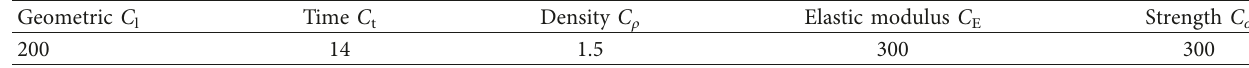
Table 1: Similarity ratios of the physical model.